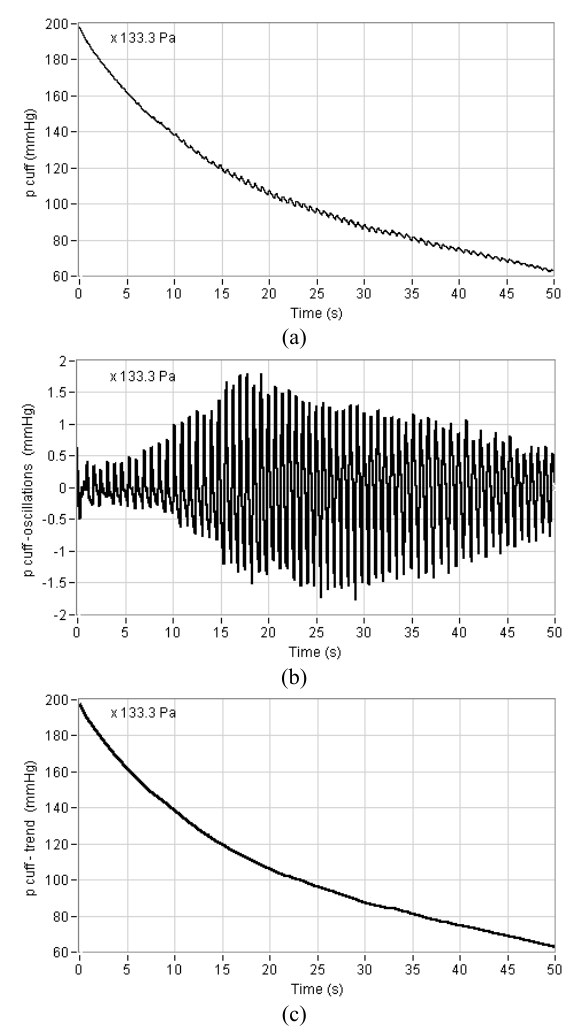
Fig. 3. The cuff pressure recorded during the deflation (a) and its components extracted by the DWT, i.e., the oscillometric oscillations (b) and the nonlinear trend